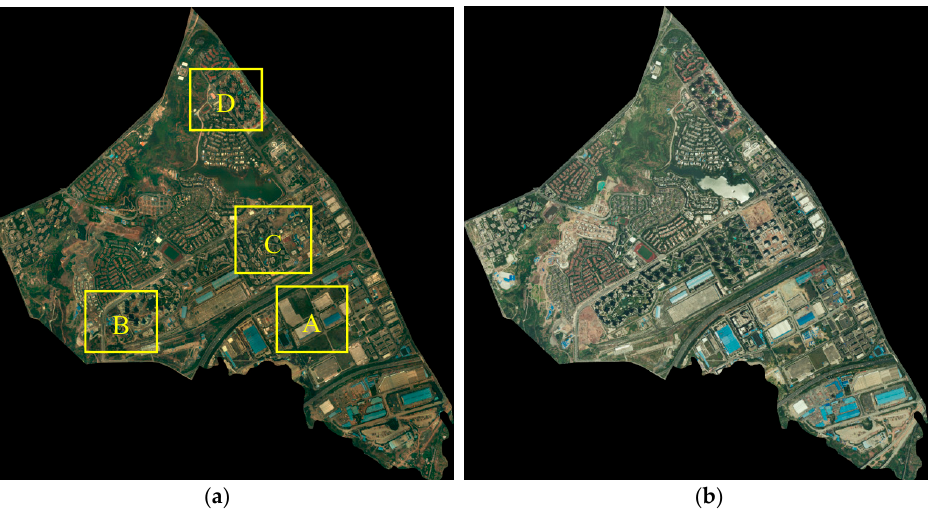
Figure 11. Overview of Dataset 1: the aerial image at ( a ) time t 1 and ( b ) at time t 2 .